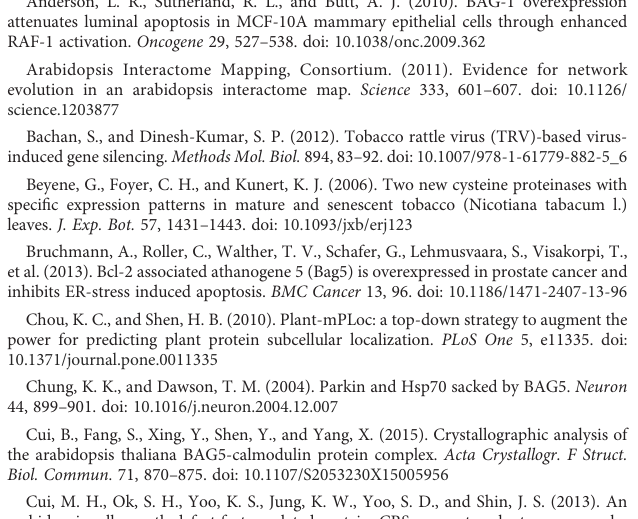
SUPPLEMENTARY TABLE 3 The predicted cis-element of each NtBAG